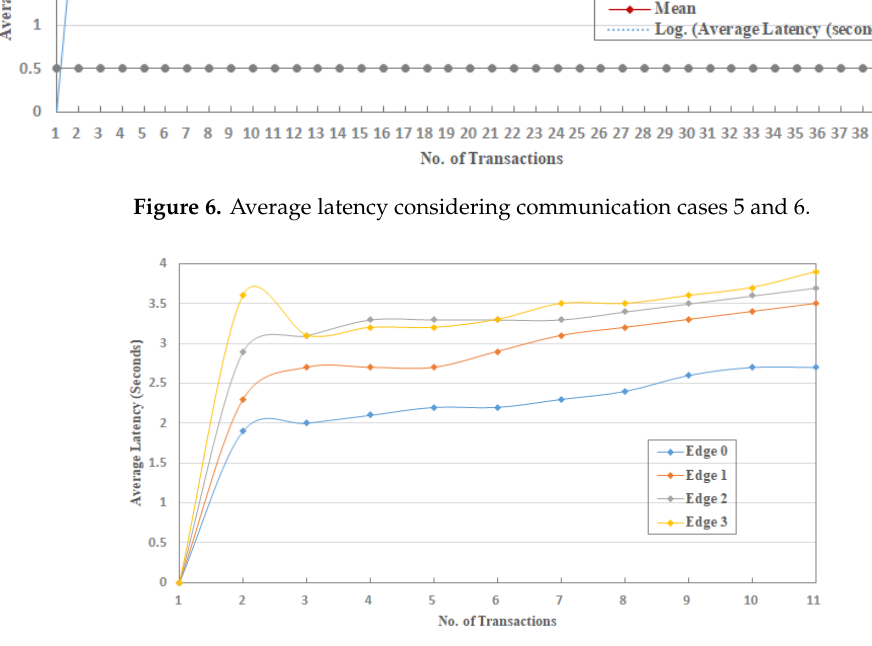
Figure 7. Average latency computed by edge nodes.